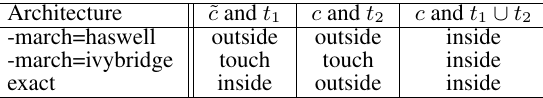
Table 1. Relationships of point c = (0 , − 0 . 01) to polygon ˜ b } and t ˜ b, ˜ a } , where ˜ t 1 := { ( − 1 , 0) , ˜ a, 2 := { (1 , 0) , a = ( − 0 . 01 , − 0 . 59) , b = (0 . 01 , 0 . 57)